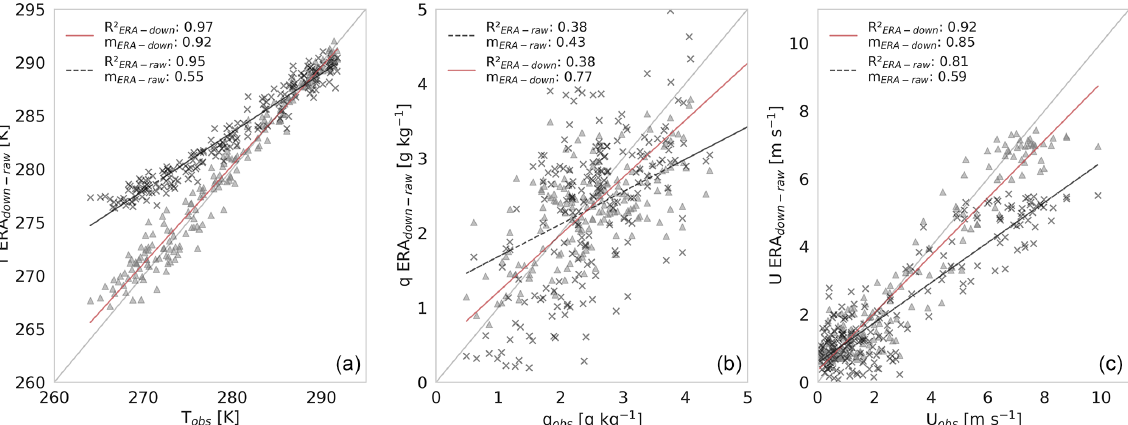
Figure 3. Comparison between ERA-5 data before and after the downscaling against the met-station SDH observations for (a) air temperature ( T ), (b) specific humidity ( q ), (c) and wind speed ( U ). Crosses represent the ERA5 down data and triangles the ERA5 raw data.